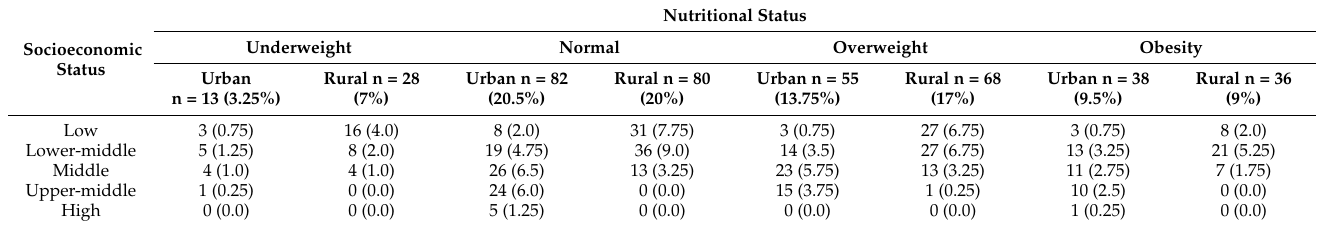
Table 2. Classification of socioeconomic status of older adults by nutritional status and geographic location.